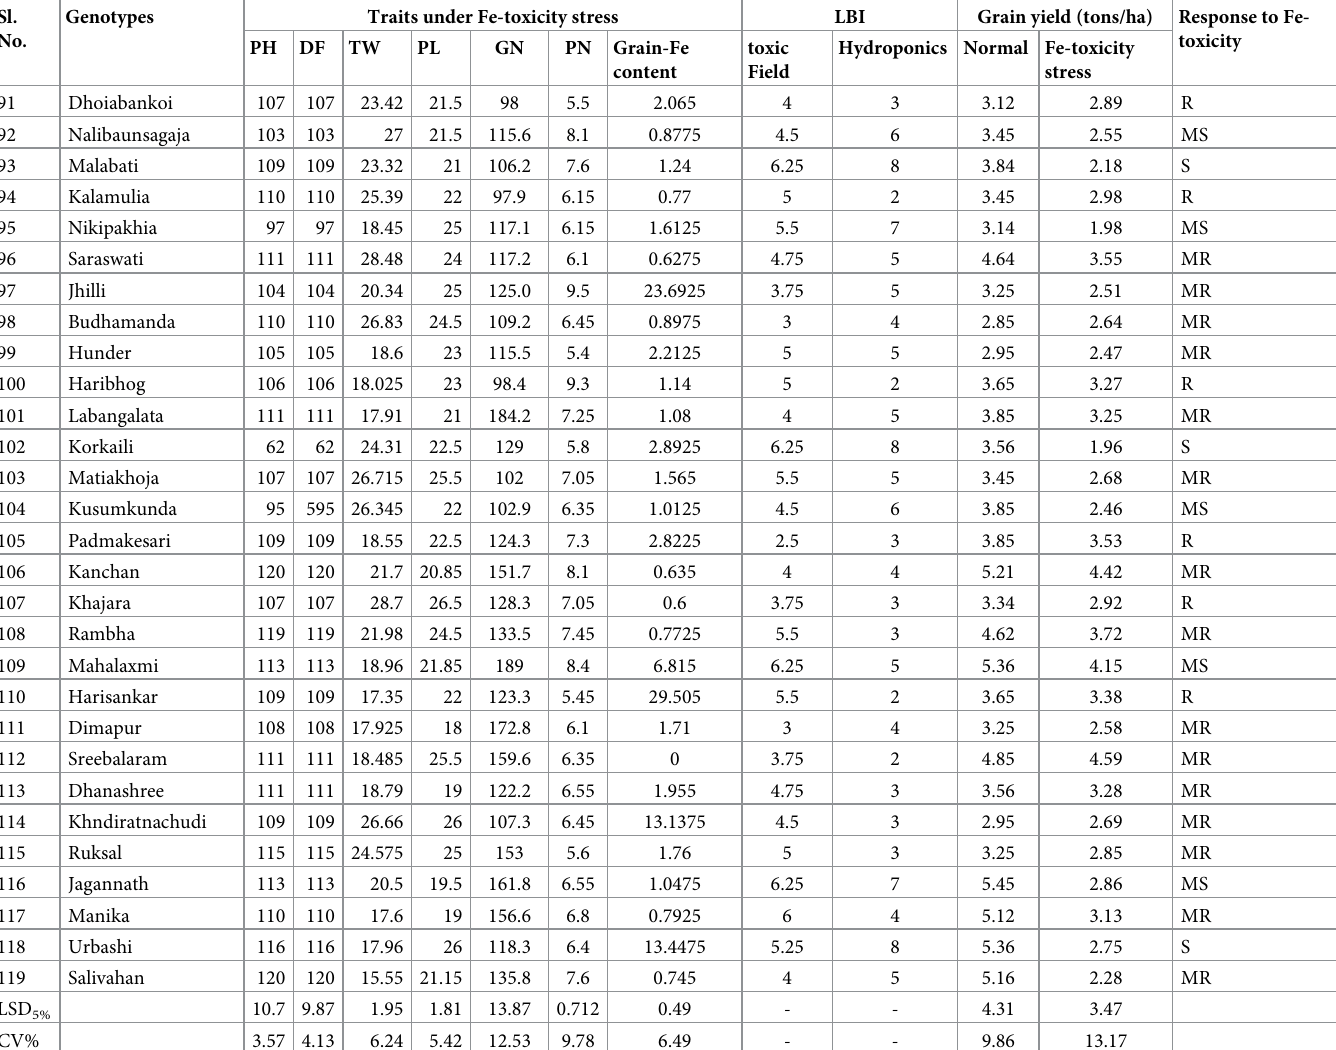
phenotyping for leaf bronzing index under controlled condition was performed during dry season, 2018. Phenotyping of germplasm lines under Fe-toxicity field The seeds were sown in the nursery bed and were transplanted in an iron toxicity hotspot field/ sick plot and a normal plot without Fe toxicity at a spacing of 15 cm apart and 20 cm between rows. The screening experiment for Fe-toxicity tolerance was planted by giving 3 lines/ each germplasm in an augmented block design with two checks and seven blocks during wet season, 2016. The shortlisted panel population was planted in a randomized complete block design (RCBD) with three replications per genotype for phenotyping during wet